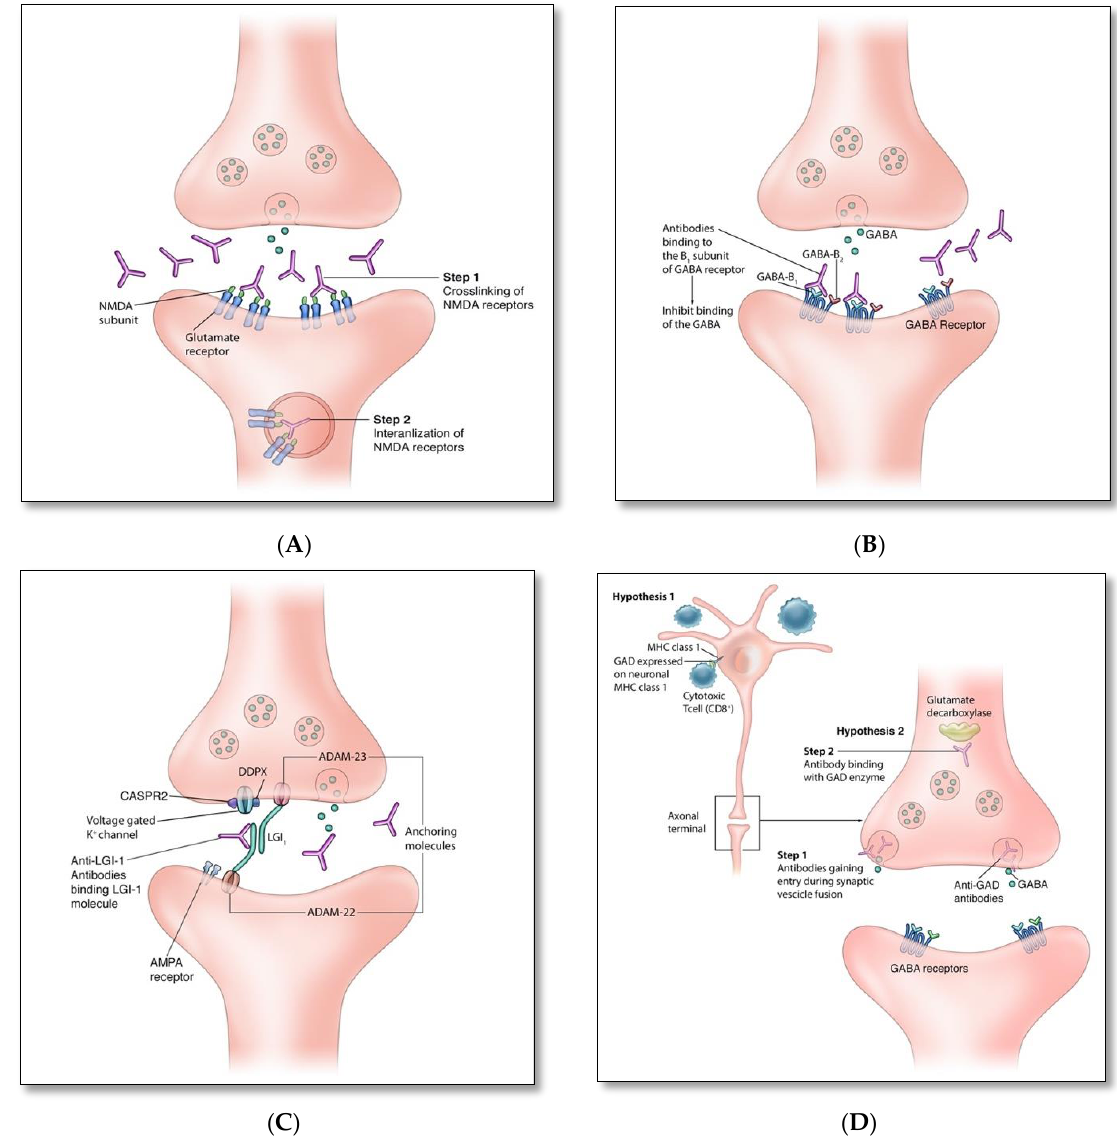
Figure 2. ( A ). Anti-NMDAR antibodies bind to an extracellular GluN1 subunit of NMDAR and re- duce NMDAR density by cross-linking and internalizing these receptors. ( B ). Similar to anti-GABA B, anti-Glycine, -dopamine-2R, -AMPA, and -GABA A receptor antibodies act through blocking recep- tors and directly preventing neurotransmitter binding to the receptor. ( C ). Disruption of channel opening and blocking function of supporting proteins: Anti-VGKC, -CASPR2, and -DDPX antibod- ies interfere with the opening of potassium channels and the release of Glutamate; anti-LGI1 anti- bodies block the binding of LGI1 with ADAM22 and ADAM23, which indirectly interferes with AMPAR function. ( D ). Intracellular synaptic protein: two proposed mechanisms of anti-GAD asso- ciated autoimmunity [8,14 – 16].